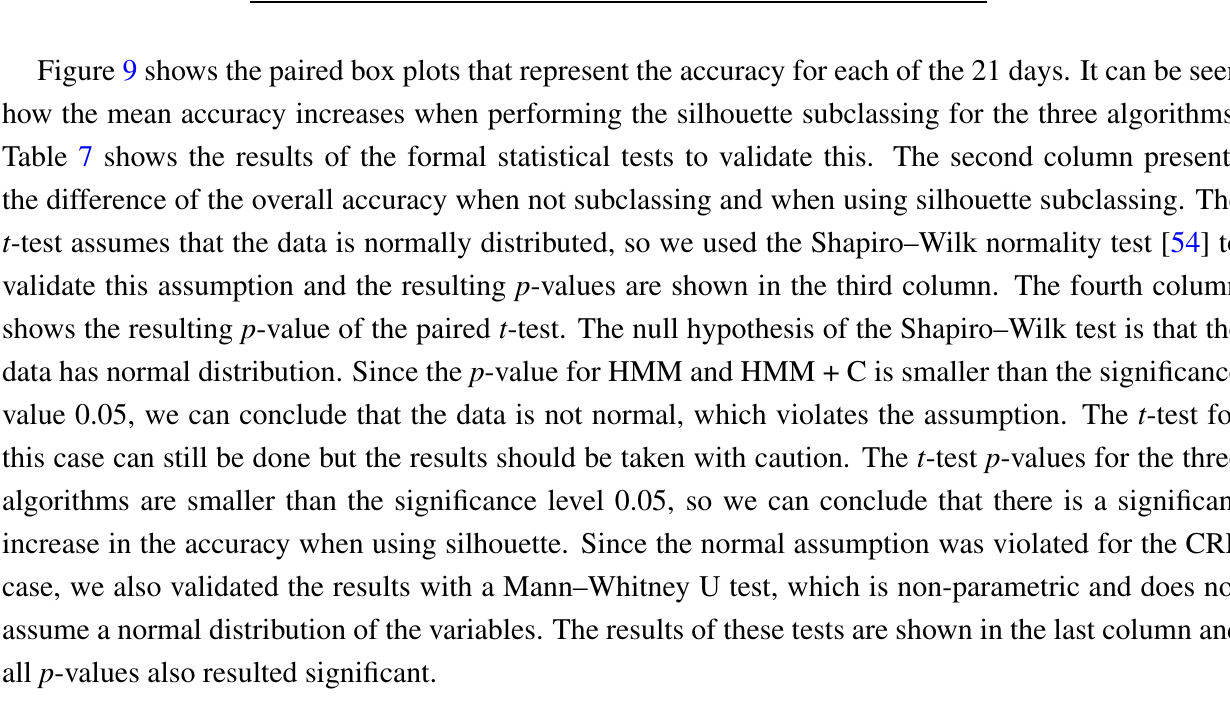
Figure 9. Paired box plots showing the accuracies for the 21